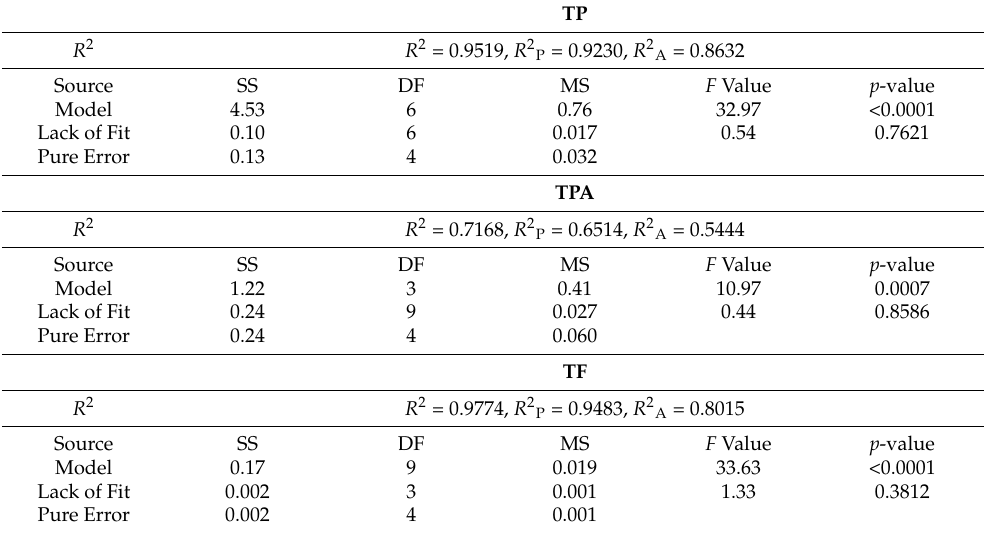
Table 5. Analysis of variance (ANOVA) and coefficients of determination ( R 2 ) for the fitted model equations of contents of total phenols (TP), phenolic acids (TPA), and flavonoids